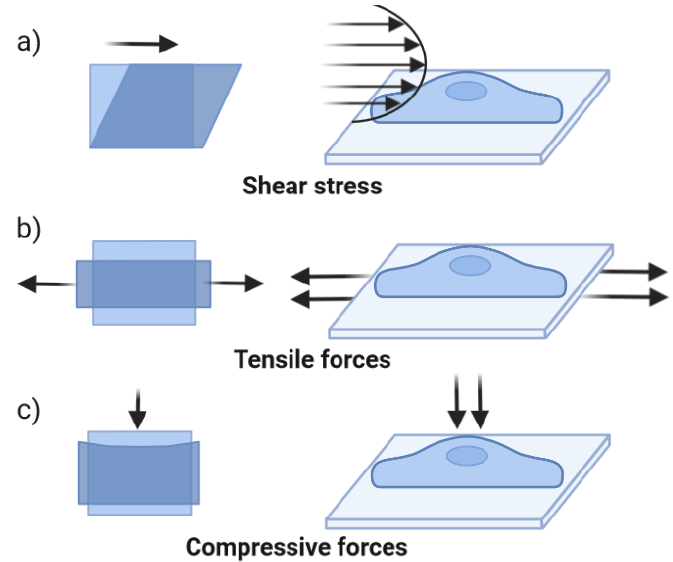
Figure 5. Different mechanical stress types acting on cells, including ( a ) shear stress, ( b ) tensile (stretch) forces and ( c ) compressive forces Simplified illustrations of the effect of each force in planar culture shown for an idealized square ( left ) and a cell ( right ).